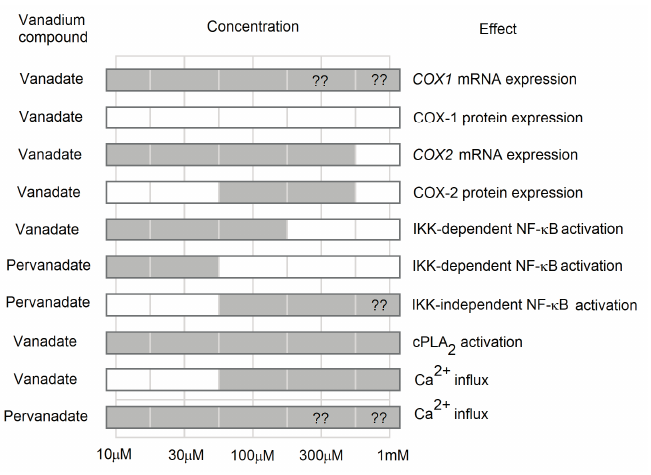
Figure 1. Effect of vanadium compounds on the selected processes in the expression and activity of COXs. Vanadium compounds at different concentrations cause changes